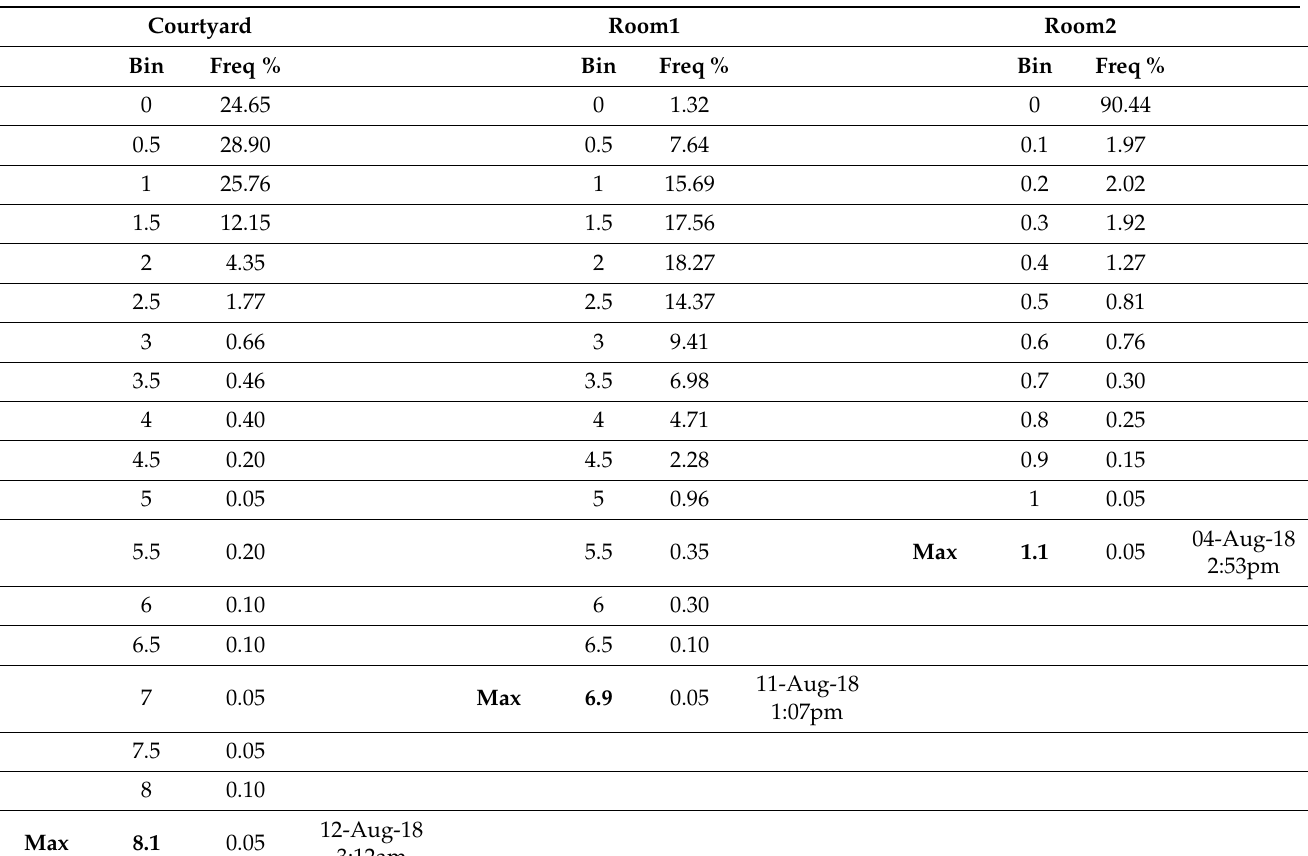
Table 6. Frequency of indoor and outdoor air velocity